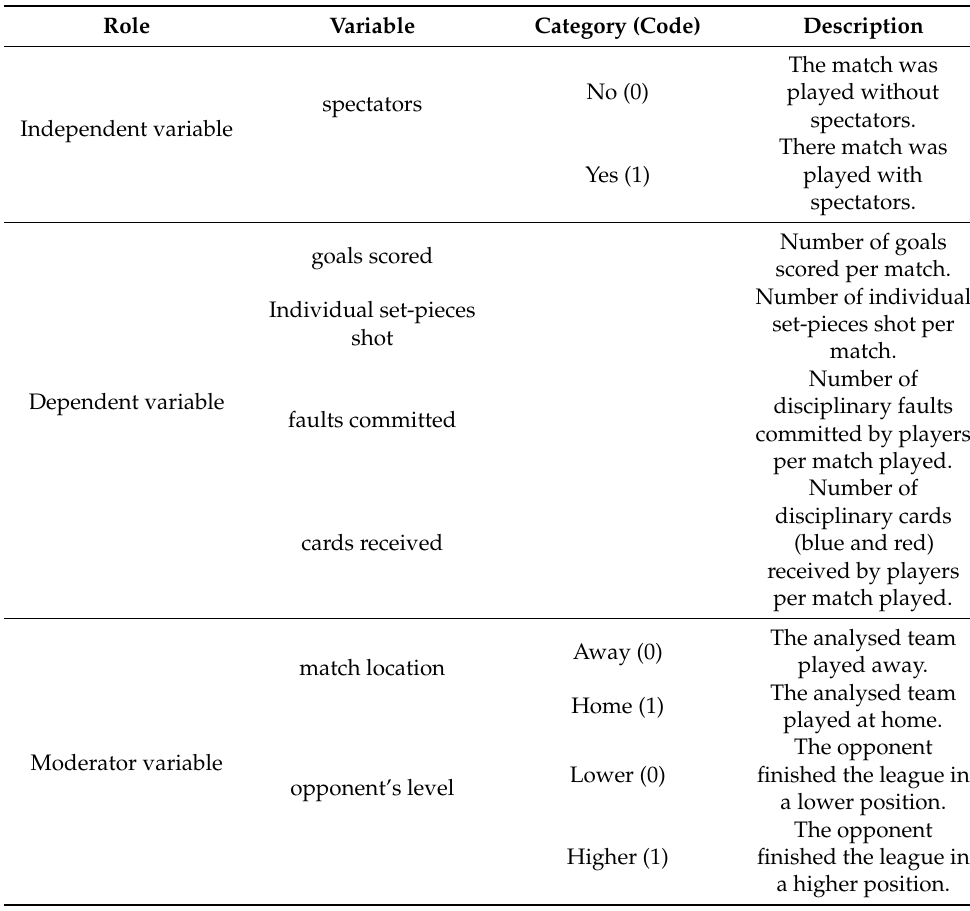
Table 1. Properties of the analysed